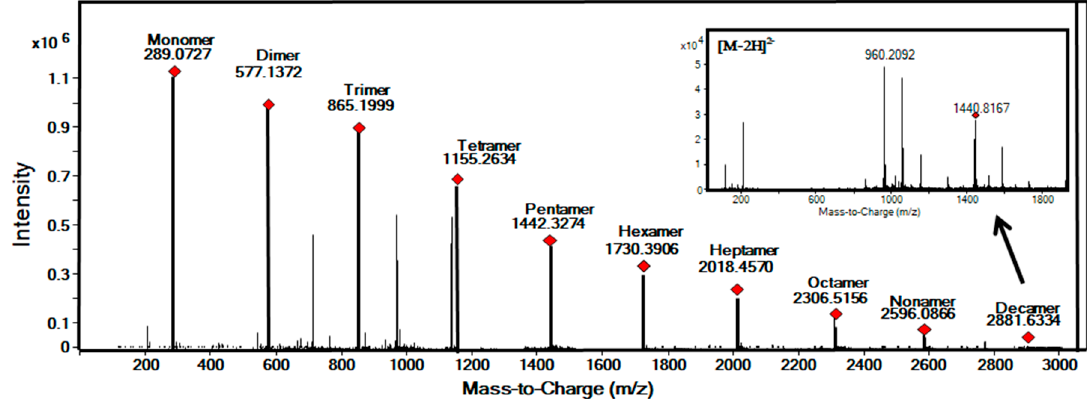
Figure 5. Negative ESI-QTOF average mass spectrum obtained for all the cocoa procyanidins fractions.